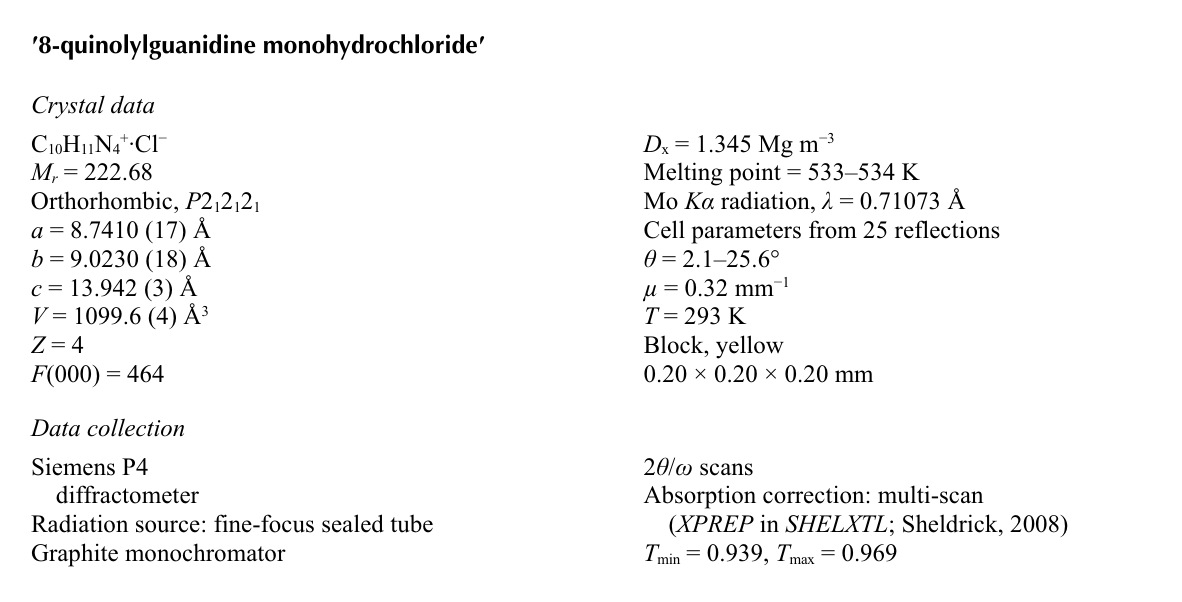
The molecular packing diagram in the crystal for